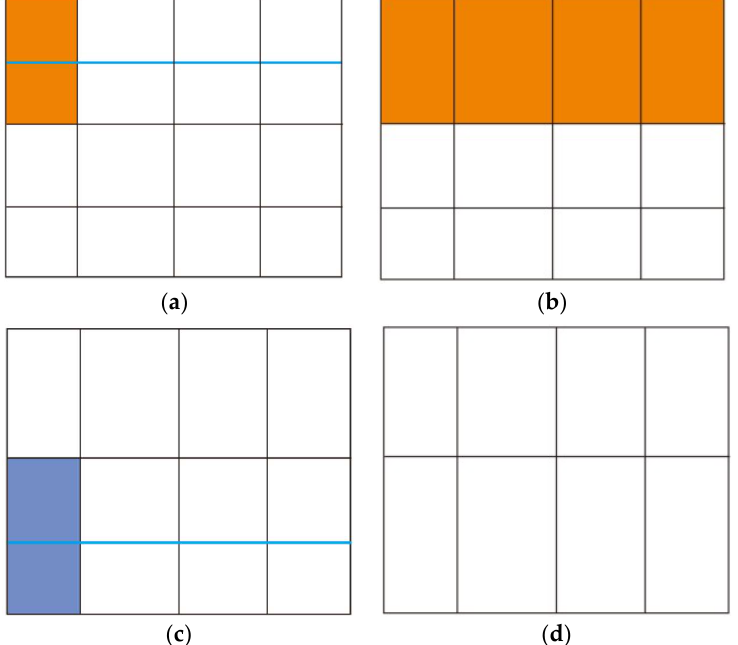
Figure 8. Iteratively identifying the starting meshes and processing the related mesh pairs: ( a ) starting meshes (orange) and the related stroke (blue) in the first round; ( b ) the selection result of the first round and the newly formed meshes (orange); ( c ) starting meshes (blue) and the related stroke (blue) in the second round; and ( d ) final selection result.